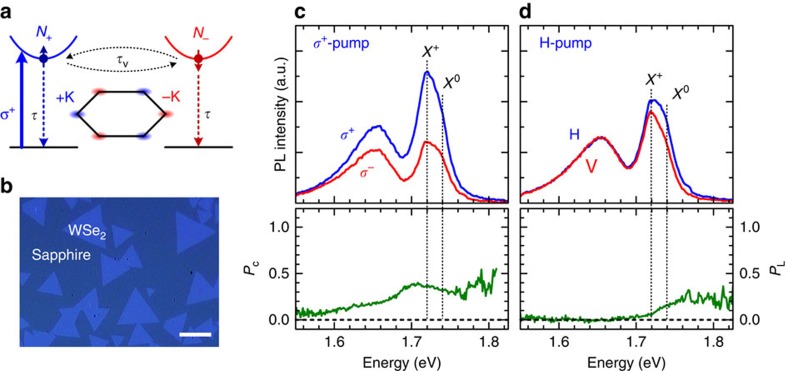
Valley polarization and coherence in monolayer WSe2.(a) Schematic of the valley-dependent exciton dynamics. The steady-state exciton population N+ (N−) in the +K (−K) valley under σ+ excitation is determined by the valley lifetime τv and the exciton lifetime τ. (b) Optical microscopy image for CVD-grown monolayer WSe2 triangles on sapphire substrate. Scale bar, 10 μm. (c) Valley polarization. The upper panel shows the σ+ (blue curve) and σ− (red curve) components of circular-polarization-resolved PL spectra under σ+ laser excitations. The lower panel shows the degree of circular polarization (PC). (d) Valley coherence. The upper panel shows the H (blue curve) and V(red curve) components of linear-polarization-resolved PL spectra under H-polarized laser excitations, where H (V) stands for horizontally (vertically) linear polarization. The lower panel shows the degree of linear polarization (PL). The emission peaks of neutral exciton (X0) and positive trion (X+) are indicated by vertical dotted lines.